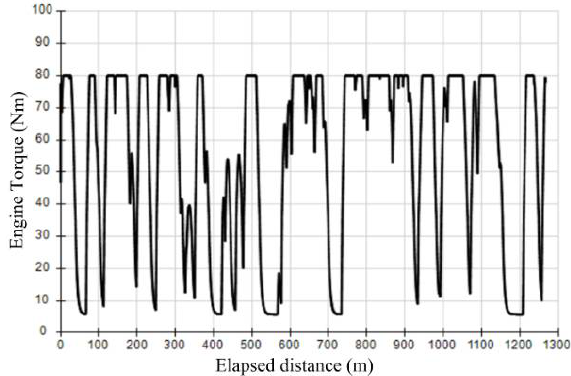
Figure 5. Instantaneous motor’s torque along the track.